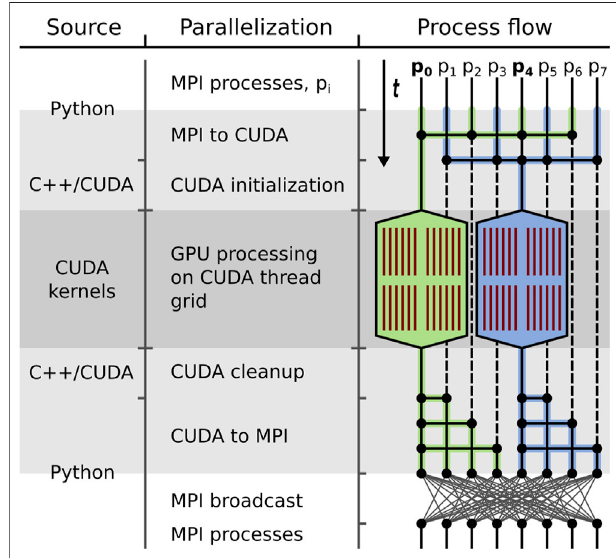
FIGURE 2 | GPU processing embedding. General template of outsourcing bottleneck computations to available GPUs in GPU ISAC. In all three columns, time fl ows from top to bottom. Shown are the different source code layers (left), the different modes of parallelization (center), and the data processing fl ow (right) while GPU ISAC transitions between data processing on the local CPUs and the local GPUs. Transition times between the CPU/MPI and GPU/CUDA parallelization are highlighted in lightgrey; GPU processing time is highlighted in dark grey. Left: The original ISAC2 implementation is written in Python, with a C++ backend. GPU ISAC employs an intermediate C++ layer to transfer data between the Python code running on the CPU and the CUDA kernels running on the GPU. Center: Embedding GPUprocessingwithintheexistingMPIparallelization fi rstrequiresatransition from MPI toCUDA. This includes are-distribution of data, as well as switching over control from using a small set of MPI processes on the CPU to a large number of threads on the GPU. This translates into initializing all necessary resourcesontheGPUandexecutingtheparallel CUDAkernelsontheGPUto perform the actual computations. Afterwards the program transitions back to the MPI parallelization by having the GPU-controlling MPI processes broadcast their results to all MPI processes. Right: From top to bottom, the control fl ow is depicted as processing switches, in this example, between eight MPI processes and a grid of 48 CUDA threads (red) spread across two GPUs (stretched hexagons). Since two GPUs are being used the overall work load is split into two parts, highlighted in green and blue, respectively. During the MPI to CUDA transition the data distributed across all MPI threads is collected in MPI processes p 0 and p 4 . These two MPI processes are responsible for GPU initialization, data transfer, and executing the CUDA kernels. While the CUDA kernels are running, the MPI processes remain idle (stippled lines). Once the kernels have stopped, processes p 0 and p 4 distribute the data again. Depending on the follow-up needs of the MPI parallelizationthiseithermeanssendingtheGPUresultstoachosensubsetof MPI processes, or performing a global data synchronization via MPI